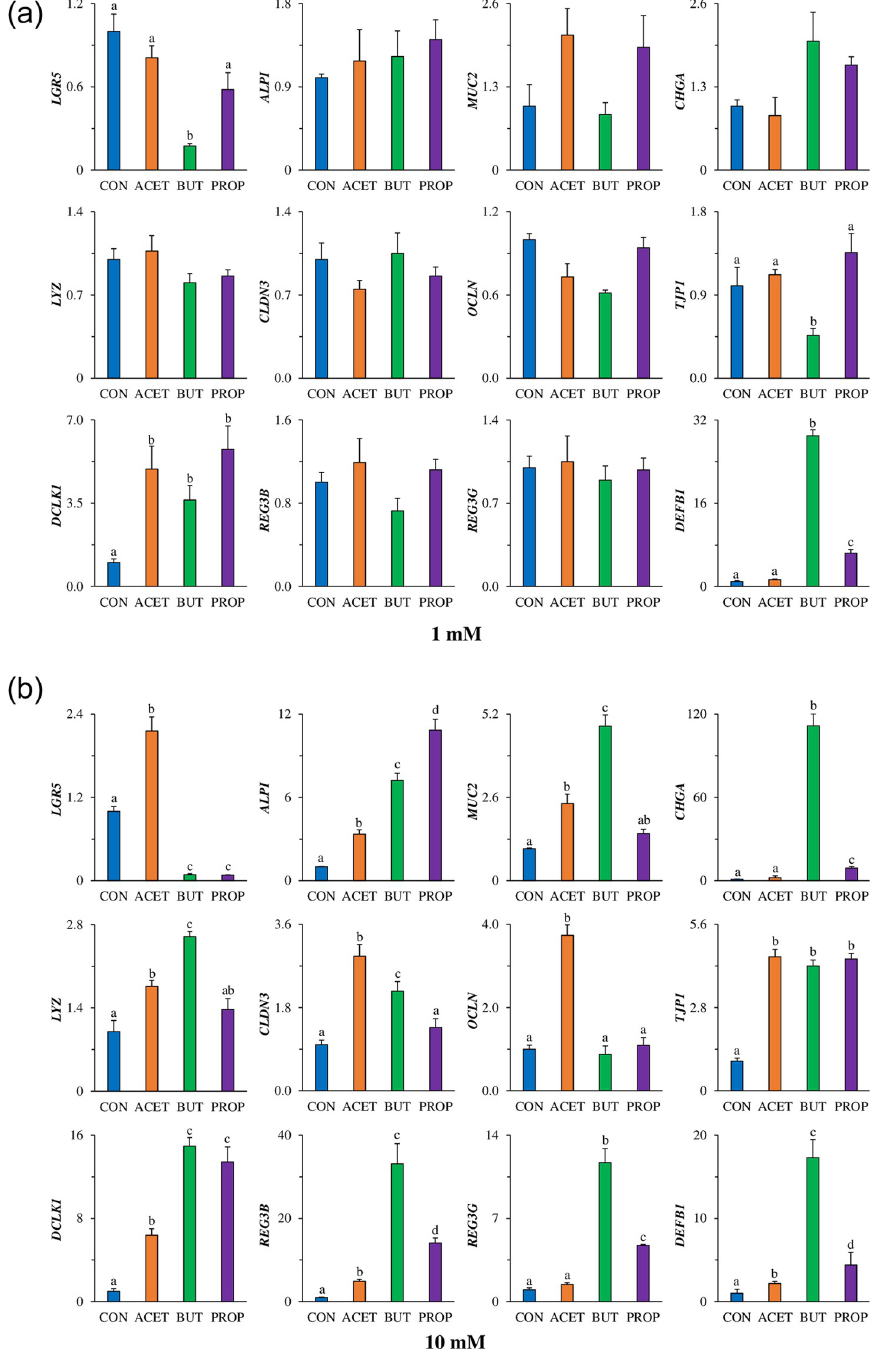
Fig 4. Effect of 24 h treatment with acetate (ACET), butyrate (BUT), or propionate (PROP) at (A) 1 mM and (B) 10 mM. Gene expression of differentiation markers: stem cells ( Lgr5) , enterocyte alkaline phosphatase ( Alpi ), goblet cell mucin 2 ( Muc2 ), enteroendocrine cell chromogranin A ( Chga ), Paneth cell lysozyme ( Lyz ), tight junction markers claudin-3 ( Cldn3 ), occludin ( Ocln ), zonula-occludens 1 ( Tjp1 ), Tuft cell marker Dclk1 , anti-microbial peptide expression Reg3 β , Reg3 γ , and beta-defensin 1 ( Defb1 ) were analyzed in human 3D duodenal enteroids. Treatments are compared to controls (CON) which are set to 1.0 and superscripts (a,b,c,d) indicate statistical significance between treatments at P < 0.05, n =